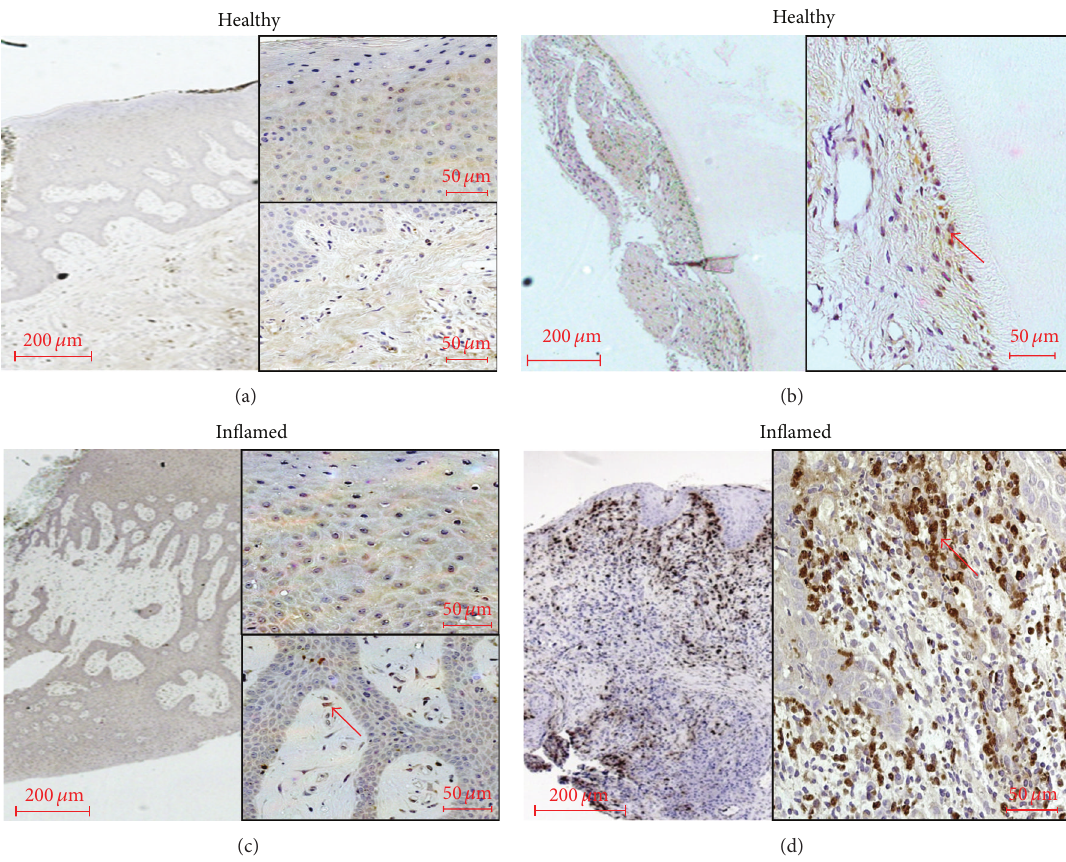
Figure 5: Catalase (CAT) occurrence in healthy and inflamed human tissue. Healthy gingival epithelium (a), periodontal ligament (b), and samples of gingivitis (c) or periodontitis (d) were obtained after the approval of the Ethics Committee of the University of Bonn and parental as well as patient’s allowance ( 𝑛 = 3 ). Polyclonal primary antibody against catalase (Abcam, Cambridge, UK) was used in a concentration of 1: 100. No immunostaining could be found in the healthy gingival epithelium. In the healthy PDL, predominantly PDL cells located near to the tooth root surfaces were stained (Figure 5(b), red arrow). In gingivitis tissue, a weak staining of gingival keratinocytes similar to healthy tissue could be seen (Figure 5(c)). Instead, in the tissue samples of patients with periodontitis a strong immunoreactivity was observed in the subepithelial layer probably referring to nuclei staining of immune cells like leukocytes. Red arrows indicate examples for the typical localisation (Figure 5(d)). The scale bars indicate 200 𝜇 m in the surveys and 50 𝜇 m in the higher magnifications, respectively.